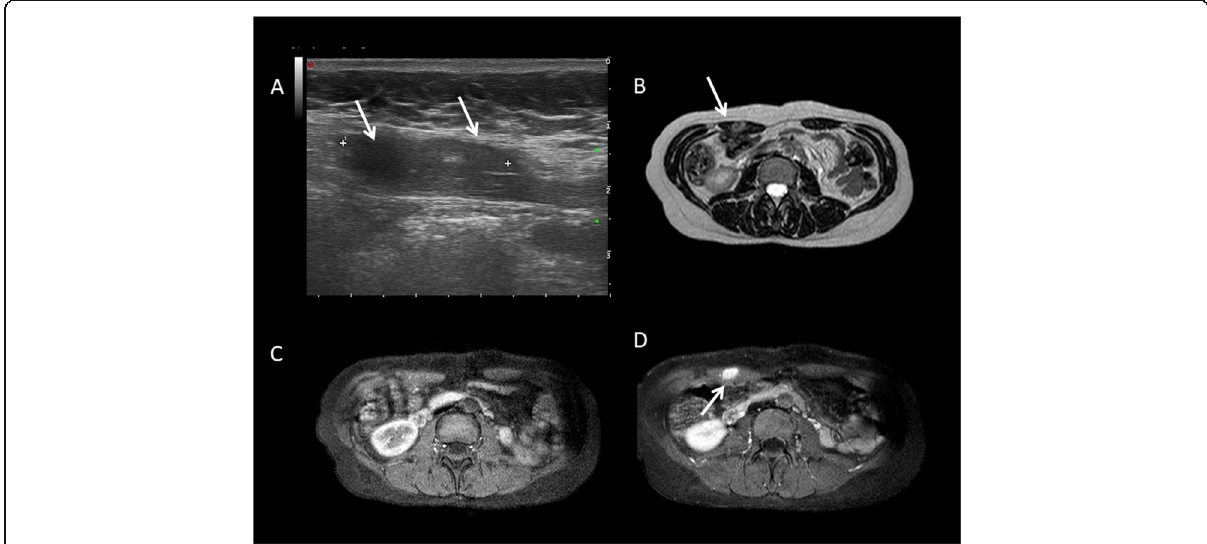
Fig. 15 Young female patient with a positive history for pregnancy and cesarean section. Abdominal wall DT (white arrow) appears as homogeneously hypoechoic masses at US examination ( a ). On MRI, it is characterized by T2 hyperintensity on T2wi ( b ) and homogeneous enhancement on fat sat T1wi ( d ). Fat sat T1wi before contrast ( c )